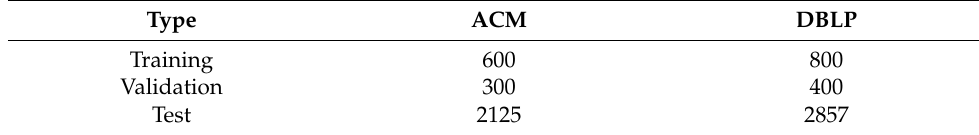
Table 3. The division of